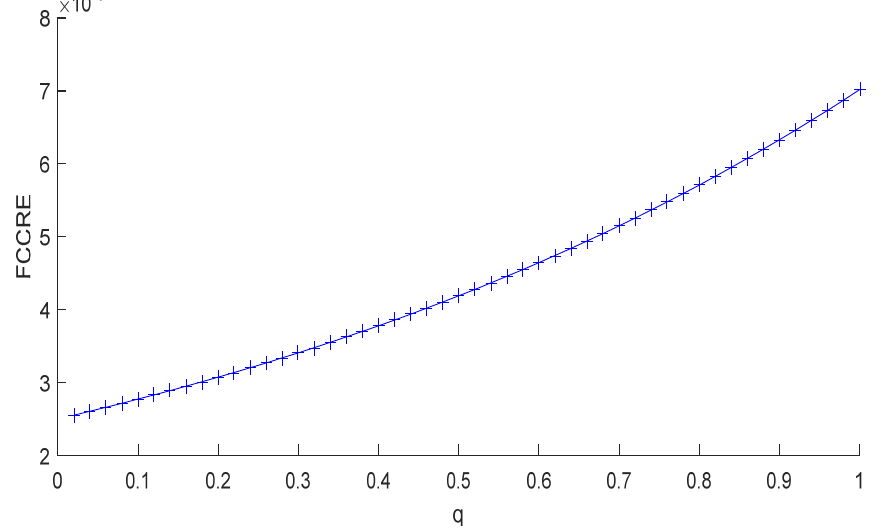
( ) | U V ε . Figure 8. The fractional conditional cumulative residual entropy of ε q ( U | V ) q